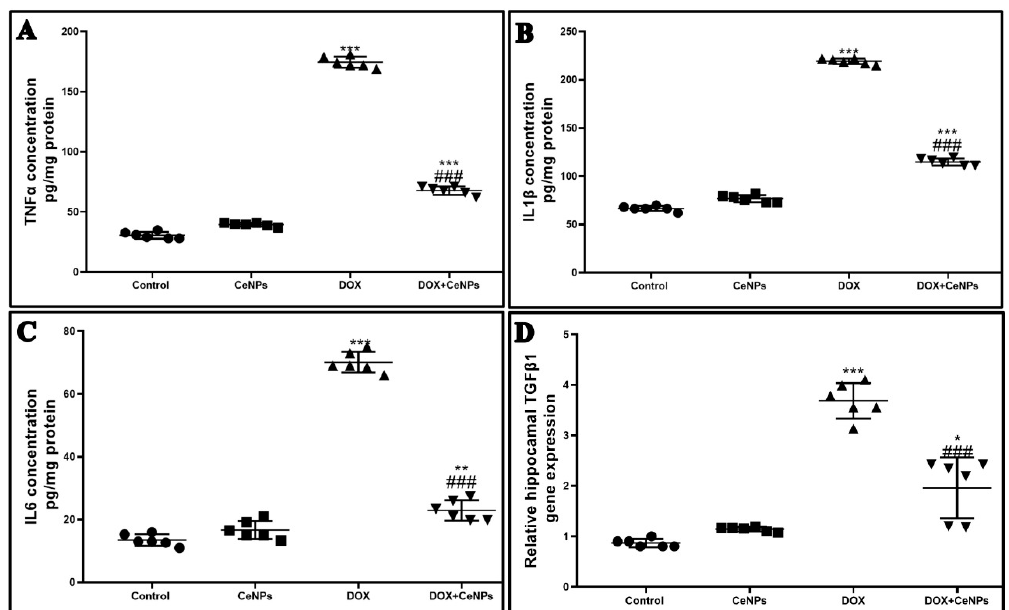
Figure 6. Effect of nanoceria treatment on proinflammatory markers measured by ELISA and on relative gene expression of TGF ‐β in different groups of rats. ( A ) TNF α protein expression. ( B ) IL1 β protein expression. ( C ) IL6 protein expression. ( D ) relative gene expression of TGF ‐β in different groups of rats. All data are expressed as mean ± SD, (one ‐ way ANOVA test followed by Tukey post hoc test was used for data analysis, *** p < 0.001, ** p < 0.01, and * p < 0.05 vs. control group, ### p < 0.001 vs. DOX group.